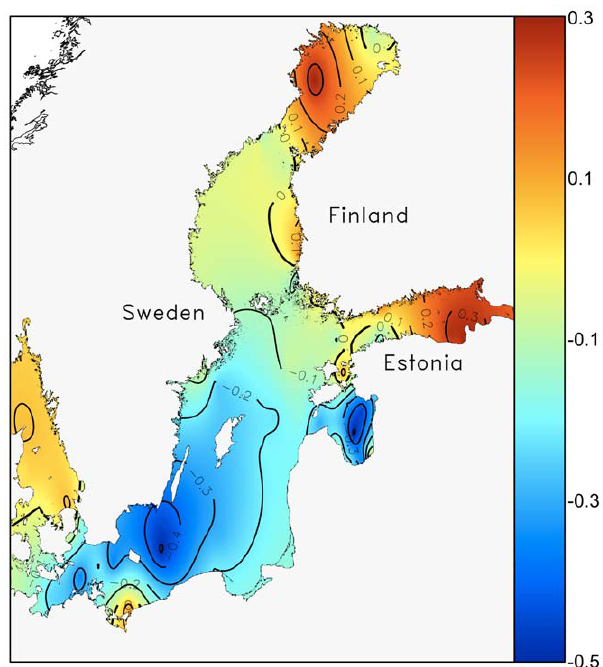
Figure 5. Shifts in the proportion of dinoflagellates over the period of ten years (1995 to 2004). The predictions were made by geographically weighted linear regression and interpolated with ordinary kriging. Positive and negative values represent the areas of increasing and decreasing dinoflagellate proportion, respectively. Thick contour lines denote boundary between areas of increasing and decreasing trend.